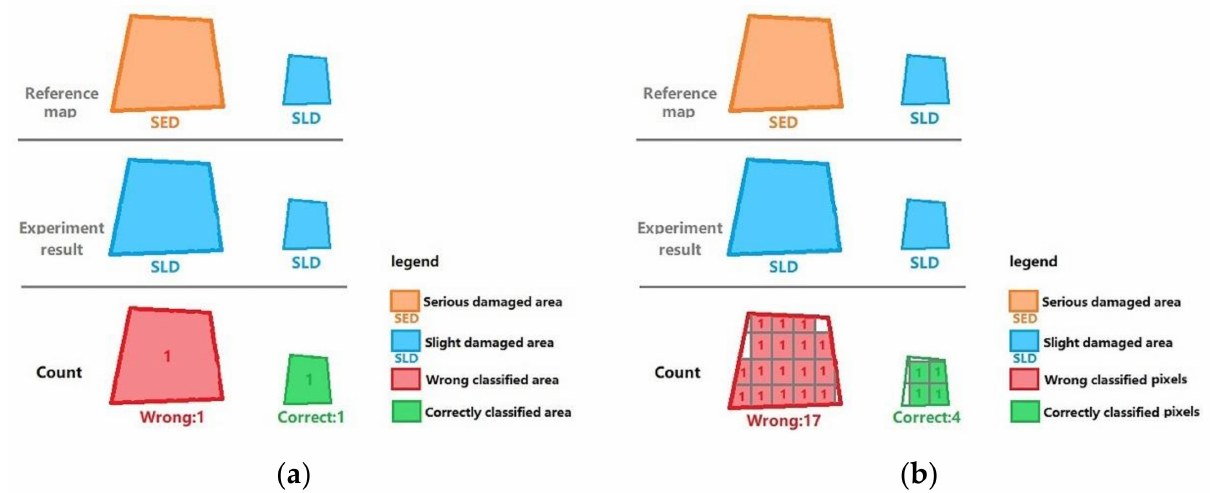
Figure 34. Diagram of two evaluation methods: ( a ) block-count-based evaluation method; ( b ) pixel-count-based evalua- tion